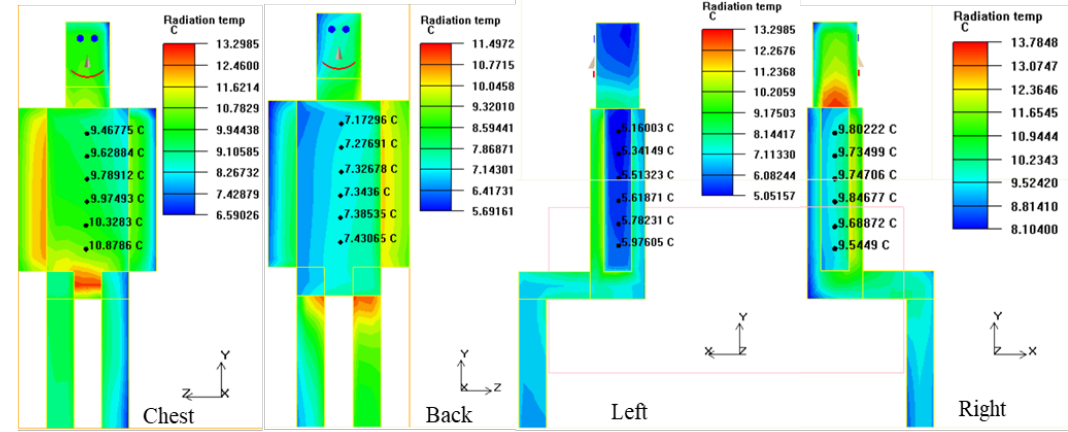
Figure 17. Radiation temperature for the human body in point 4 of Lhasa at 10:00.